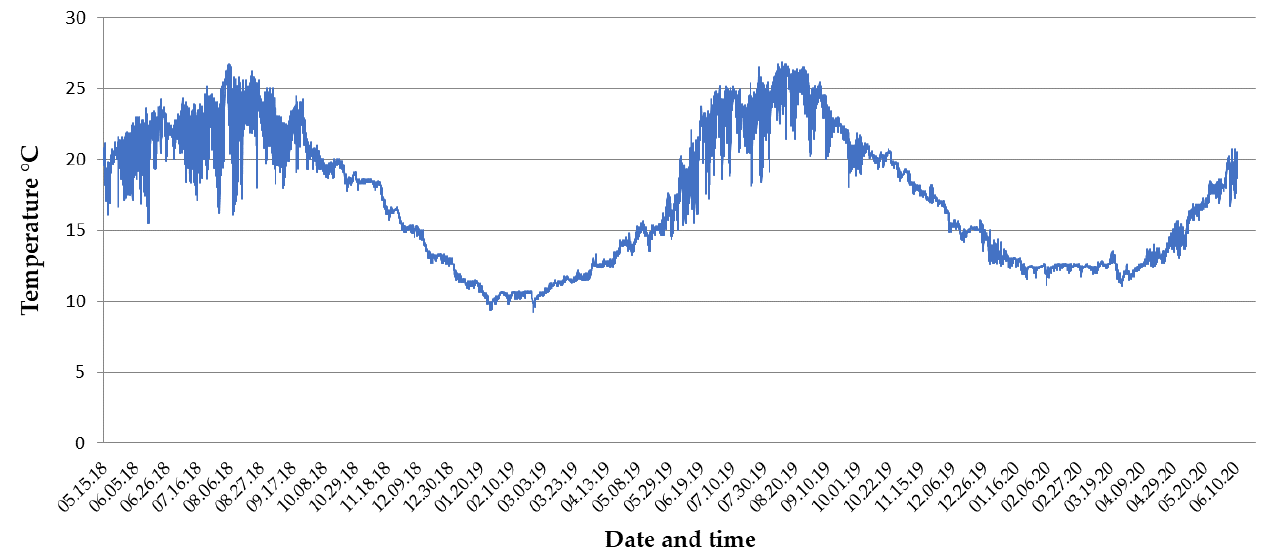
Figure 9. Seawater temperature in Javorike Cove at a depth of 12 m in Cymodocea seagrass meadow, recorded by permanent temperature recorder over a period of two years, from May 2018 to June 2020 (1 h recording interval).